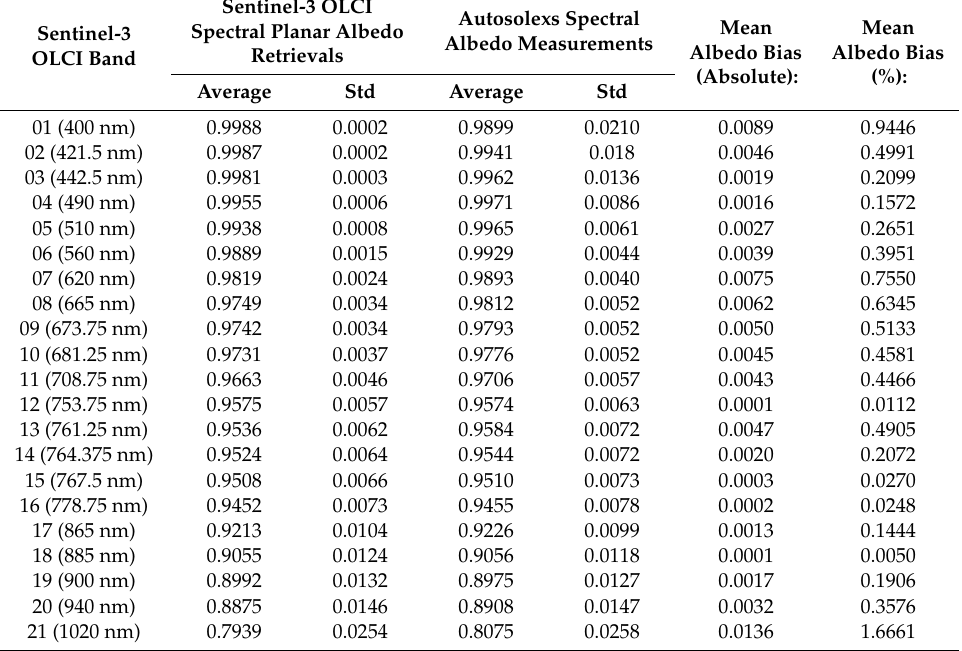
Table 3. Comparison between the Sentinel-3 OLCI spectral planar albedo retrievals and the Autosolexs spectral albedo measurements over the 2016–2017 and 2017–2018 summers at Dome C,